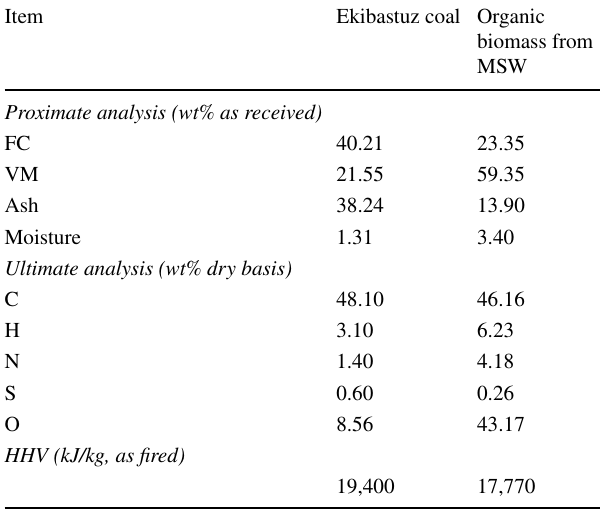
Table 5 Fuel properties for Ekibastuz coal and organic fraction of the